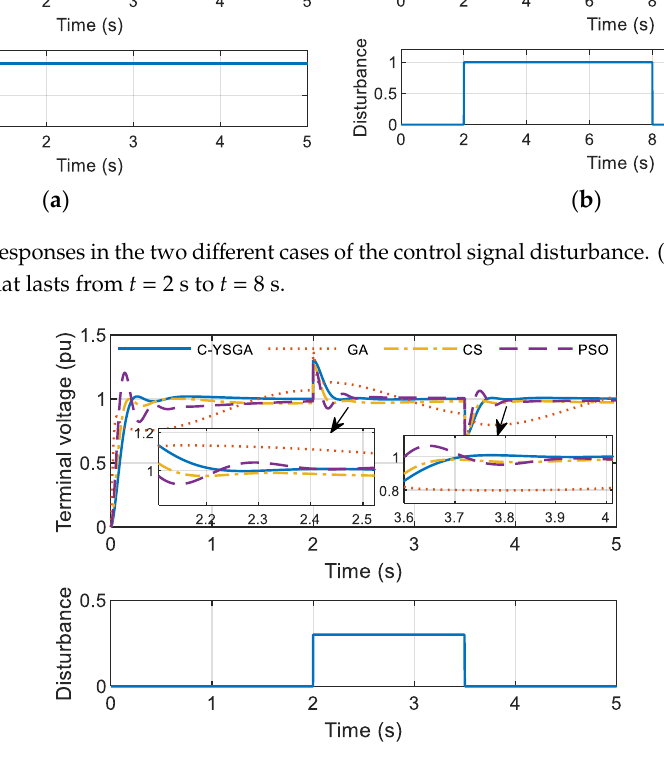
Figure 19. Step responses in the case of load disturbance.